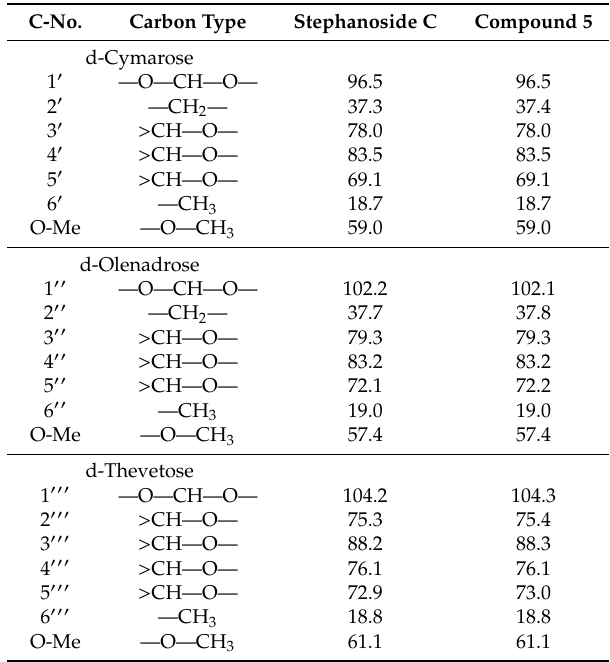
Table 5. The 13 C NMR chemical shifts of stephanoside B and compound 6 ( δ : ppm). C-No.